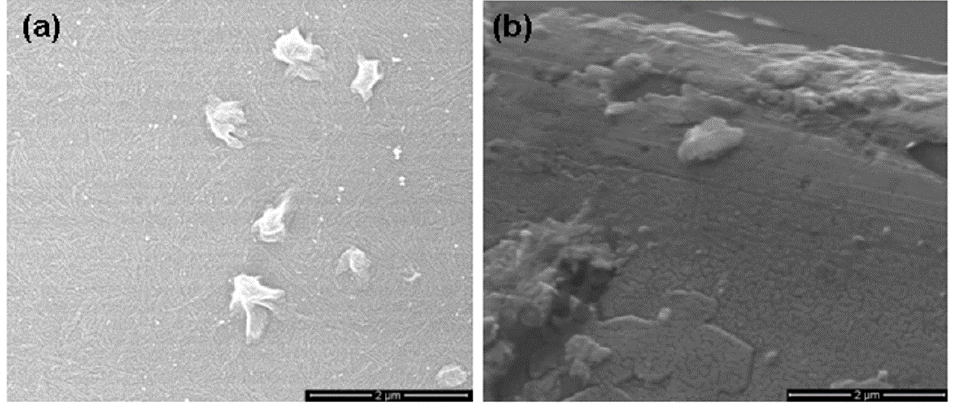
Figure 6. SEM images of 200 °C annealed porous GaAs (sample C). ( a ) surface, ( b ) cross-section view.